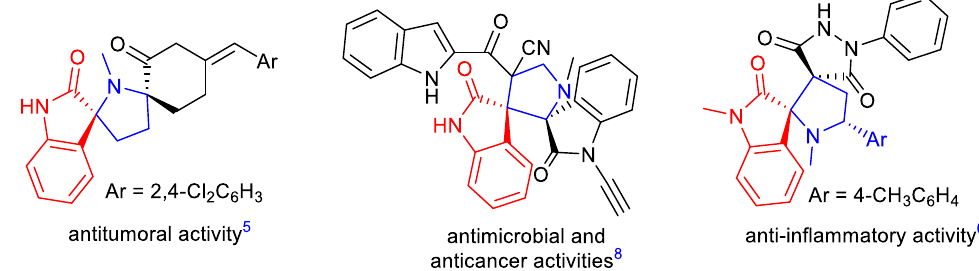
Figure 1. Examples of biologically active compounds containing spiro[oxindole-2,3′-pyrrolidine] units.